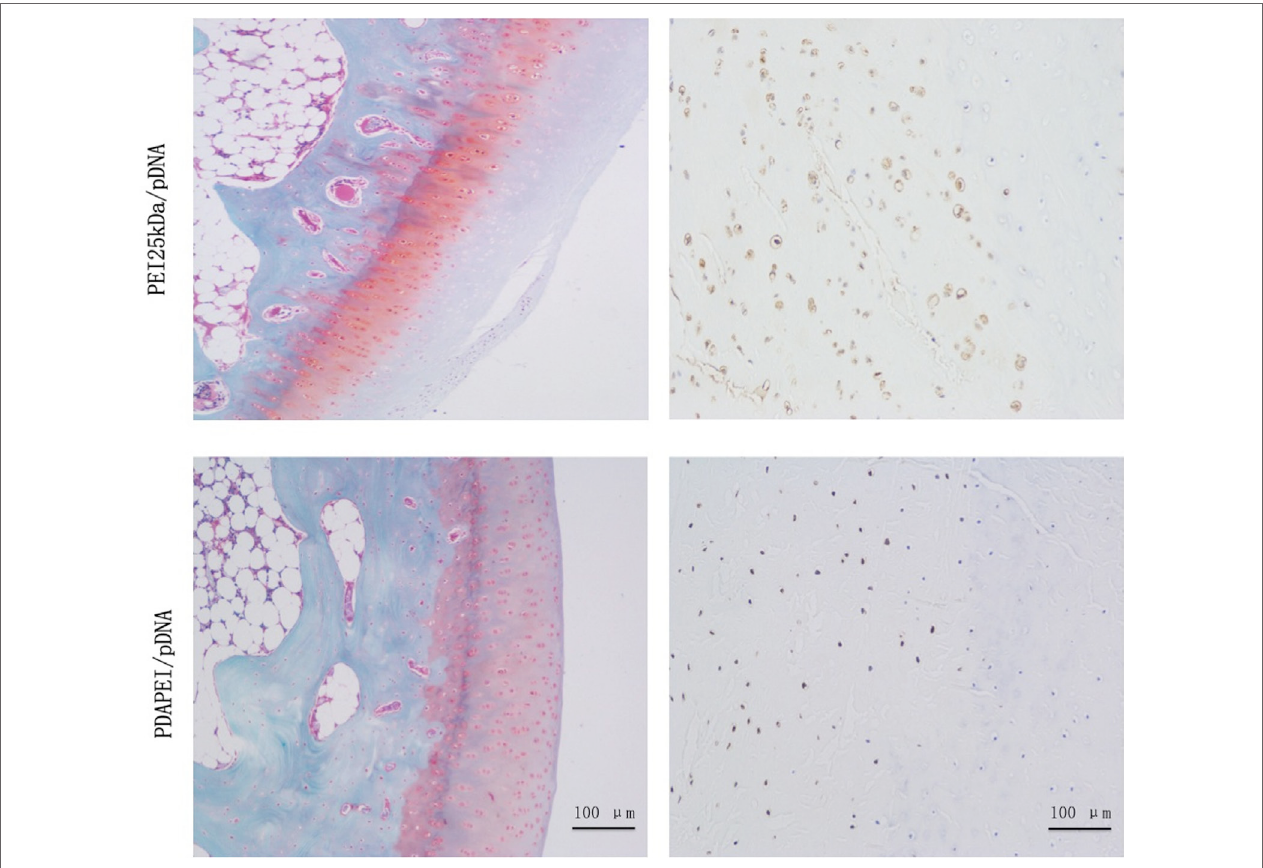
FigUre 7 | histological examination . (a) Safranin O/fast green staining (red: cartilage, gray green: cytoplasm). (B) anti-TNF- α staining (brown: TNF- α ) of 4 experimental group (PDAPEI/pDNA, PEI 25 kDa/pDNA, PEI 1.8 kDa/pDNA and saline control group) and normal knee joint. Scale bar = 100 μ